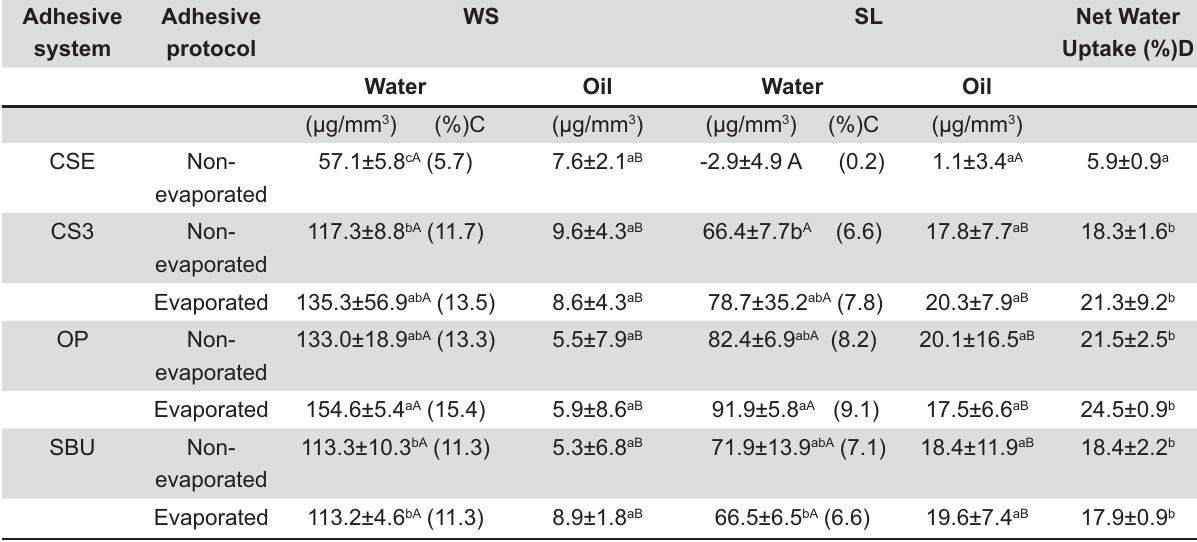
(cid:30)(cid:5)(cid:3)(cid:18)(cid:4)(cid:23)(cid:8)(cid:5)(cid:6)(cid:4)(cid:8)(cid:31)(cid:4)(cid:5)(cid:13)!(cid:9)"(cid:8)(cid:15)(cid:13)#$&(cid:16)(cid:8)(cid:27)(cid:28)(cid:29)(cid:19)(cid:19) 3 "(cid:17)’’(cid:4)(cid:6)(cid:4)(cid:13)(cid:25)(cid:8)(cid:18)**(cid:4)(cid:6)(cid:8)(cid:24)(cid:5)(cid:23)(cid:4)(cid:8)(cid:3)(cid:4)(cid:25)(cid:25)(cid:4)(cid:6)(cid:23)(cid:8)’(cid:12)(cid:6)(cid:8)(cid:6)(cid:12)+(cid:23)(cid:8)(cid:5)(cid:13)(cid:14)(cid:8)(cid:3)(cid:12)+(cid:4)(cid:6)(cid:8)(cid:24)(cid:5)(cid:23)(cid:4)(cid:8)(cid:3)(cid:4)(cid:25)(cid:25)(cid:4)(cid:6)(cid:23)(cid:8)’(cid:12)(cid:6)(cid:8)(cid:24)(cid:12)(cid:3)(cid:18)(cid:19)(cid:13)(cid:23)/(cid:8)(cid:23)(cid:17)(cid:28)(cid:13)(cid:17)(cid:7)(cid:24)(cid:5)(cid:13)(cid:25)(cid:8)(cid:15)*<=(cid:26)=>(cid:16) Water sorption is given in absolute terms (g/mm 3 ) and in relative terms (%) to provide comparisons to literature values (cid:2)(cid:8)>V(cid:26)$(cid:8)(cid:27)(cid:28)(cid:29)(cid:19)(cid:19) 3 =0.5710 mg/mm 3 x100 5.71 mg/100 mm 3 =5.7 % [Malacarne, et al. 12